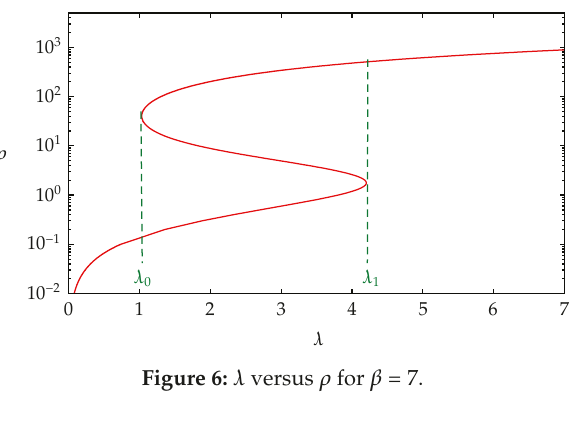
Figure 6: λ versus ρ for β (cid:3) 7.